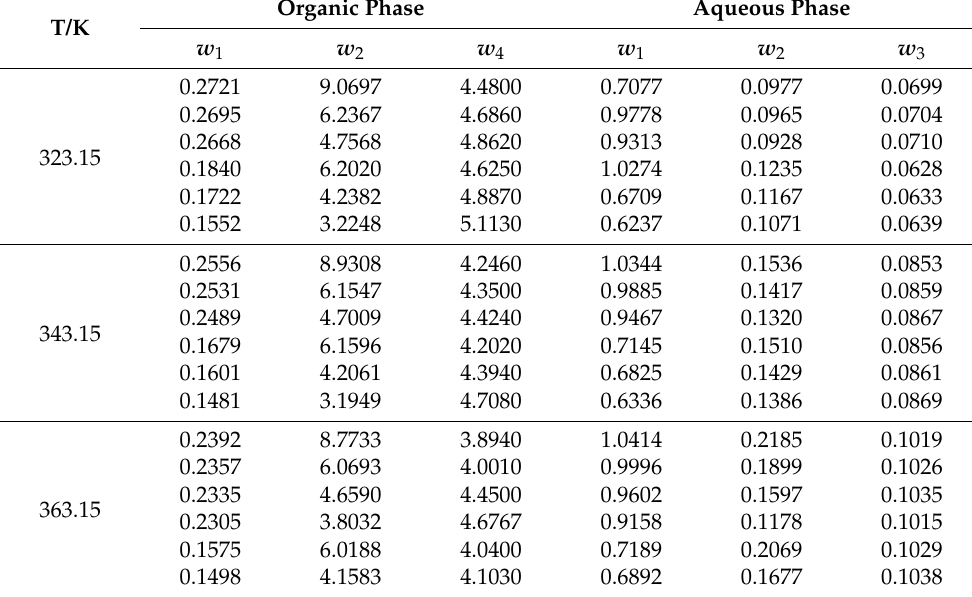
Table 2. Experimental LLE data for quaternary system FA (1) + OF (2) + OC (3) + water (4).